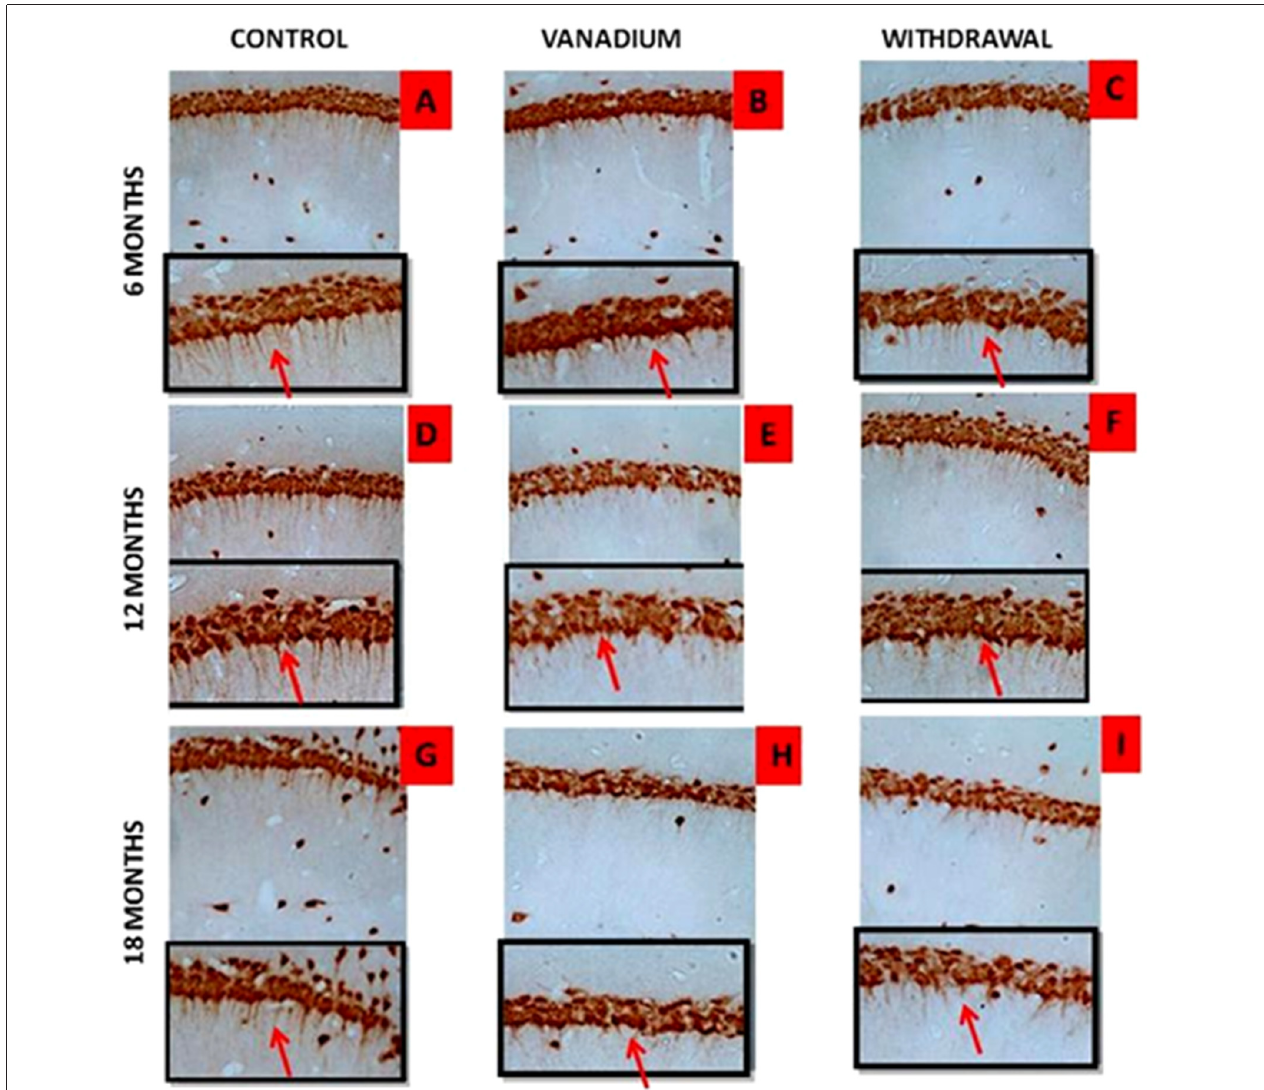
FIGURE 9 | Dendritic arborization is lost with increasing vanadium exposure. NeuN immunohistochemistry revealed progressive loss of apical dendrites of the pyramidal cells of the dorsal hippocampal CA1 region. In (A,D,G) control pyramidal cells of hippocampus CA1 are identified, in which are notorious the presence of apical dendrites relative to (B,E,H) with evidence of the dendritic loss after chronic V treatment. Withdrawal groups (C,F,I) showed reversal effect relative to vanadium exposed groups (B,E,H) . Magnification: × 200, inset: ×